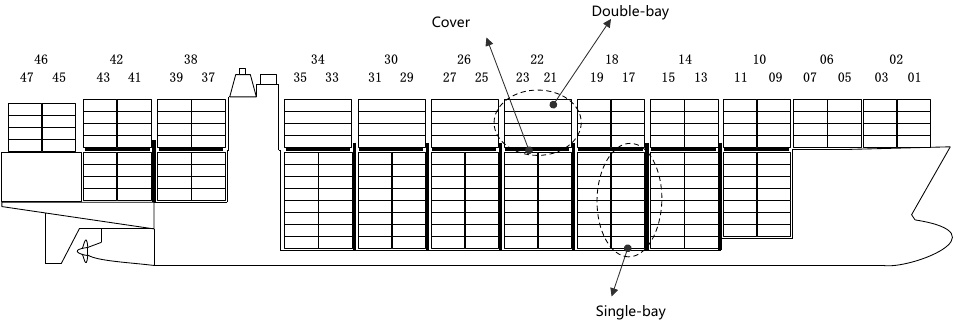
Figure 1. Schematic diagram of the container